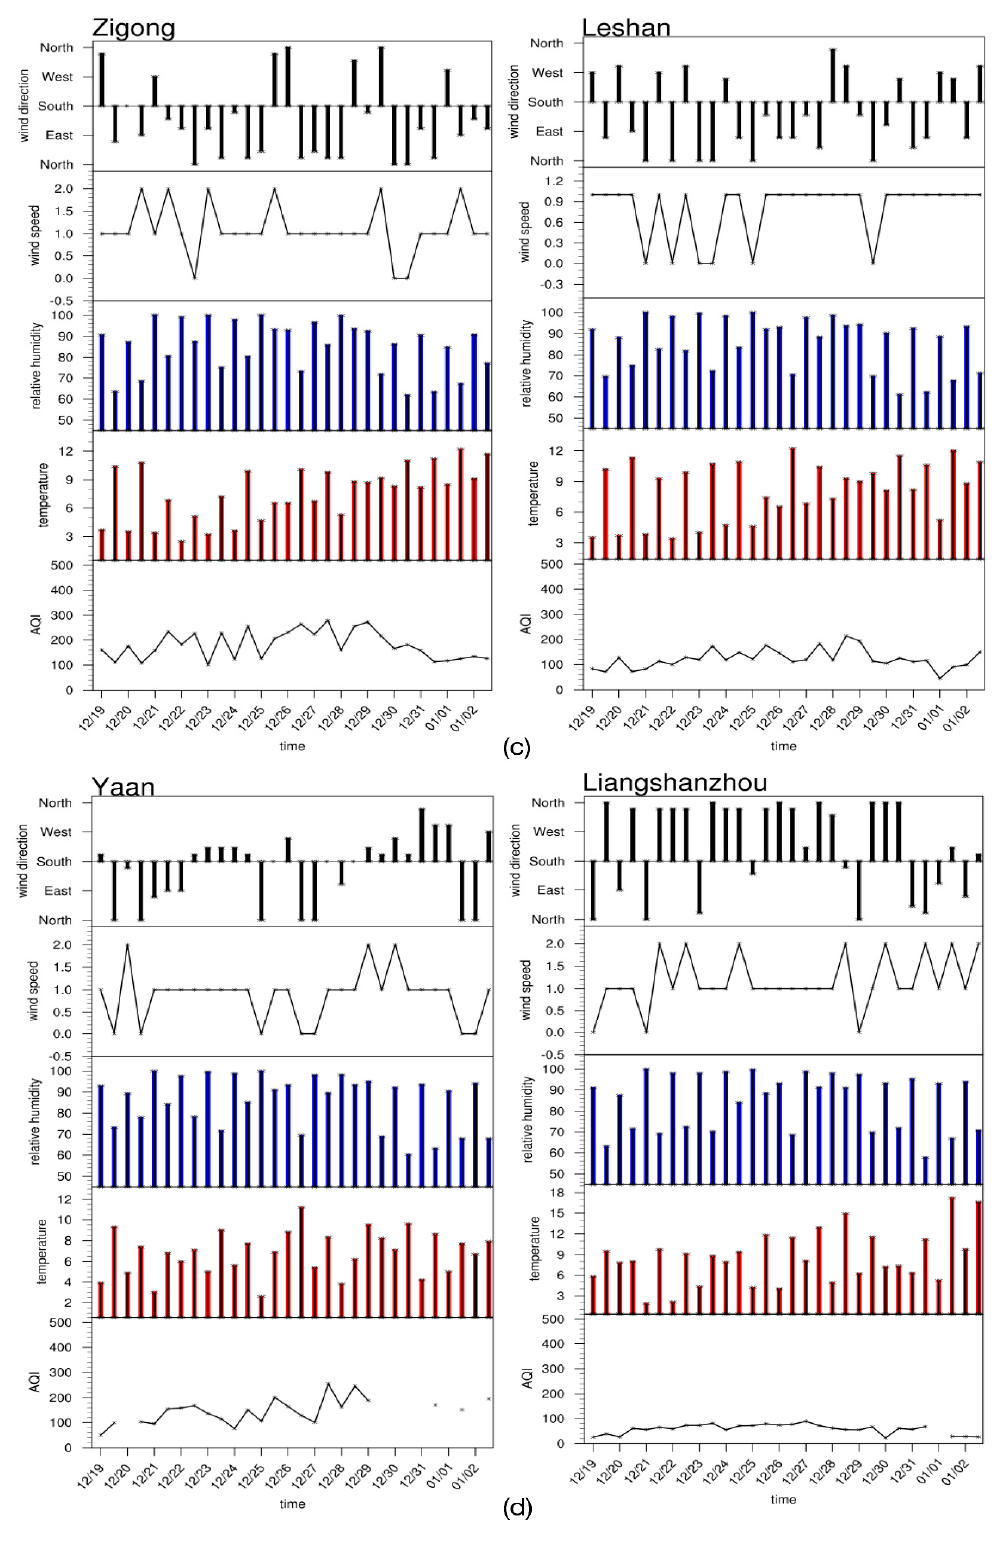
Figure 7. The time series of surface meteorological factors (wind direction, wind speed, relative humidity, and ground temperature) and AQI in the eight chosen cities in northern Sichuan ( a ), eastern Sichuan ( b ), southern Sichuan ( c ) and western Sichuan ( d ) from 19 December 2017 to 2 January